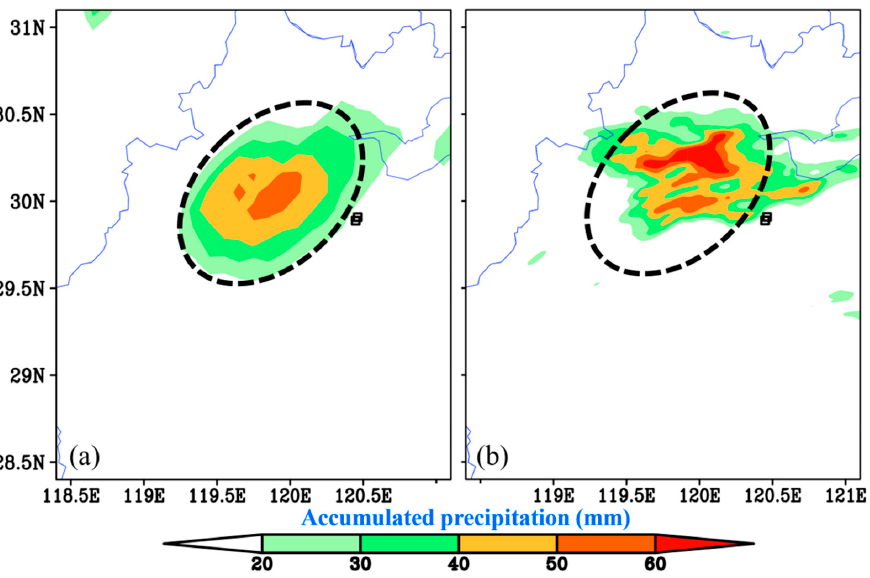
Figure 5. Panel ( a ) shows the observed (GPM) 3 h accumulated precipitation from 12:00:00 UTC to 15:00:00 UTC, 14 May 2021 (shading; mm), where the small black boxes mark the locations at which the tower toppling appeared. Panel ( b ) is the same as ( a ) but for the simulation.